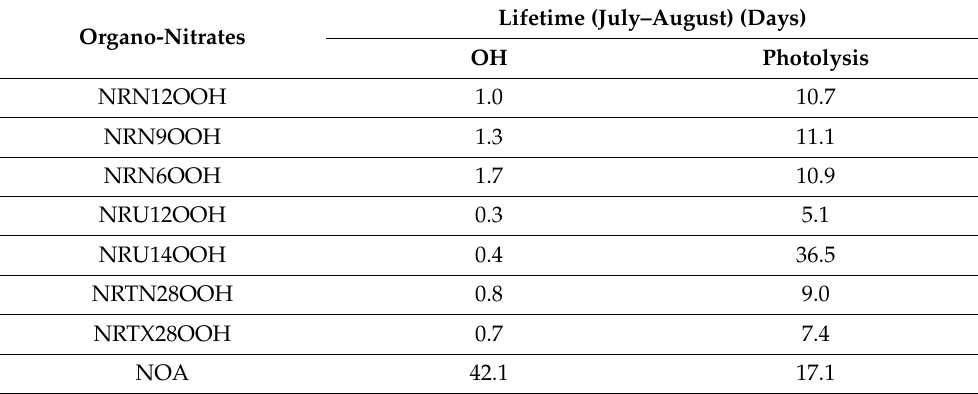
Table 2. The estimated atmospheric lifetimes of 8 selected organo-nitrates (derived from NO 3 ) with respect to OH and photolysis